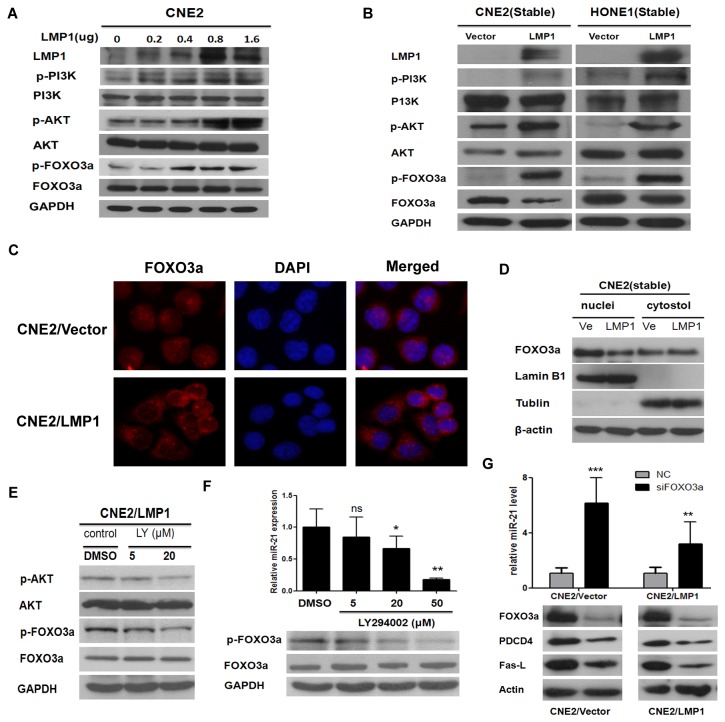
LMP1 expression results in the activation of the PI3K/AKT pathway and the inactivation of FOXO3a.(A, B) Western blot analysis for LMP1, p-PI3K, PI3K, p-AKT, AKT, p-FOXO3a and FOXO3a expression in cells treated as in Figure 2B and 2C. (C) CNE2/Vector, CNE2/LMP1 cells were harvested for the analysis of FOXO3a by immunofluorescent staining. Cell nuclei were stained with 4’, 6-diamidino-2-phenylindole (DAPI). (D) CNE2/LMP1 and CNE2/Vector (Ve) cells were collected for the analysis of total FOXO3a by immunoblotting the nuclear and cytosolic fractions. Lamin B1 and Tubulin were used as controls for nuclear and cytoplasmic compartment, respectively, and β-actin was used as a loading control for both fractions. (E) CNE2/LMP1 cells were serum_starved for 24 h and treated with LY294002 (LY) at indicated doses for 12 h. pAKT, AKT, pFOXO3a, FOXO3a and GAPDH (loading control) were detected by immunoblotting. (F) To analyze the association between p-FOXO3a and miR-21, western blot analyses of p-FOXO3a, FOXO3a and GAPDH, or real-time PCR analysis for miR-21 were performed in CNE2/LMP1 cells treated as in (E). The value of miR-21 in DMSO_treated cells was designated as 1 (ns, not significant, * P < 0.05, ** P < 0.01 vs DMSO_treated cells). (G) Both CNE2/Vector and CNE2/LMP1 cells were transfected with 50nM siFOXO3a or negative control. FOXO3a, PDCD4 and Fas-L were detected by immunoblotting. The level of miR-21 was analyzed by qRT-PCR. The value of miR-21 in negative control treated cells was designated as 1 ( ** P < 0.01, *** P < 0.001 vs negative control treated cells).